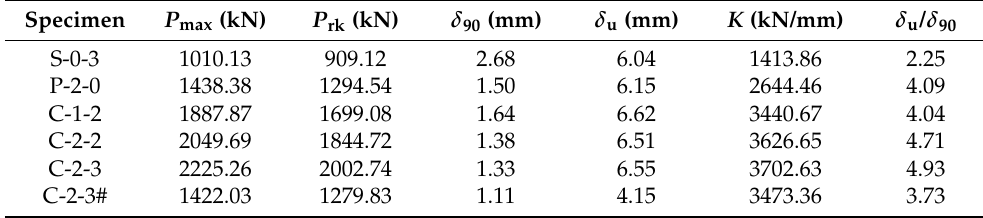
Figure 10. Evaluation of shear resistance and ductility.